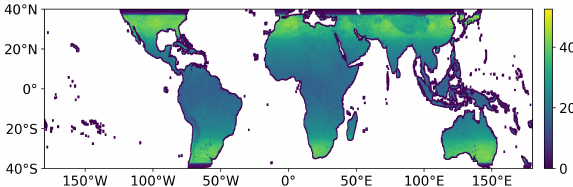
Figure 1. Mean number of CYGNSS observations in time in the 0.1° grid. Colour scale ranges from dark blue (zero) to yellow (maximum of ∼ 40 observations per cell in the tropics) The weighted average and standard deviation values of CYGNSS reflectivity in this moving window for every pixel are used to fill the grid’s time steps. They are respectively noted Γ mean and Γ std . This results in a weekly 0.1° ( ∼ 11 km) grid of two parameters that describe the average level of reflectiv- ity and the dispersion or heterogeneity in a pixel at each time step. Figure 2 presents the spatial patterns of yearly averaged values of Γ mean and Γ std per pixel. These variables are used for further analysis along with some ancillary data in section